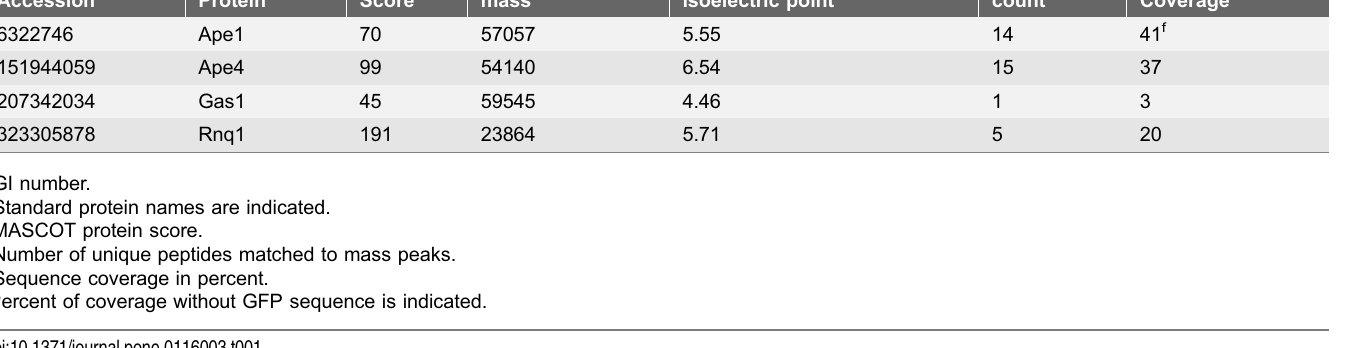
Table 1. Identification of proteins in DRAFs isolated by treatment with SDS from the BY4742 [ PIN + ] strain and its [ pin 2 ] derivative. Accession a